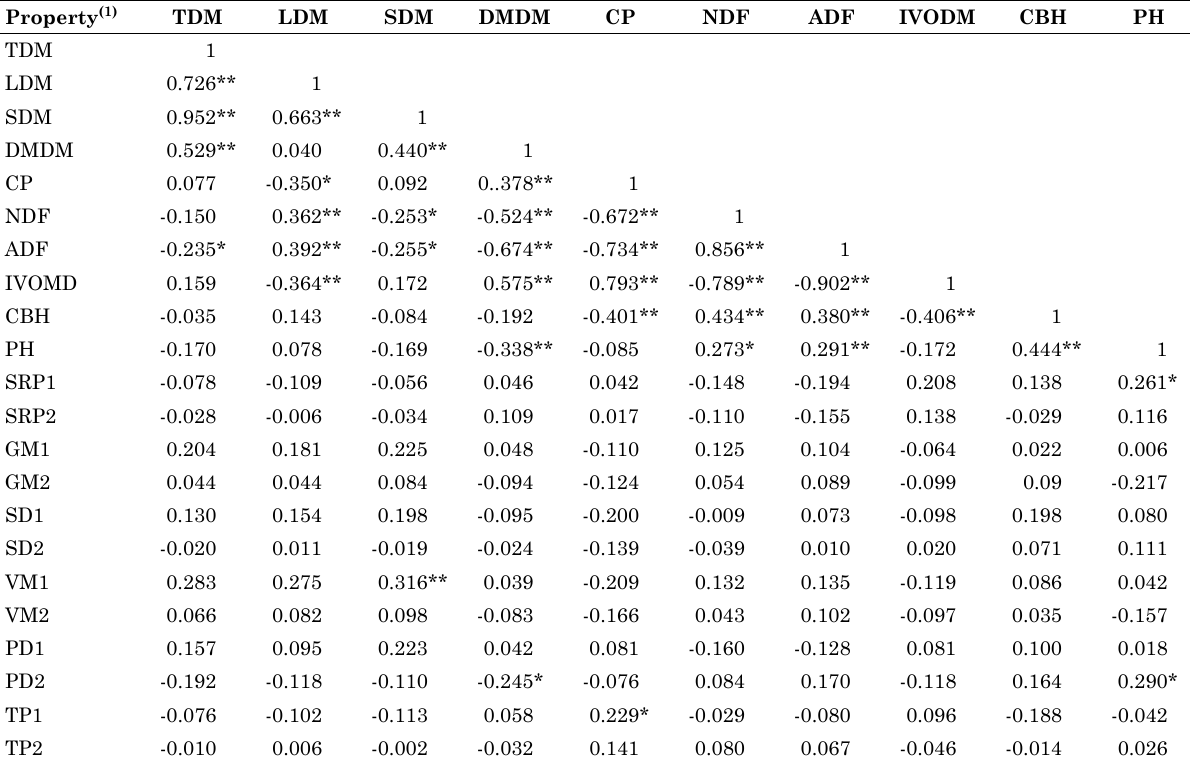
Table 2. Correlation matrix between some aspects of Eucalyptus urograndis dendrometric properties, yield and bromatological properties of forage, and physical properties of a Quartzipsamment (Entisol) soil in a silvopastoral system in Ribas do Rio Pardo, MS, Brazil Property